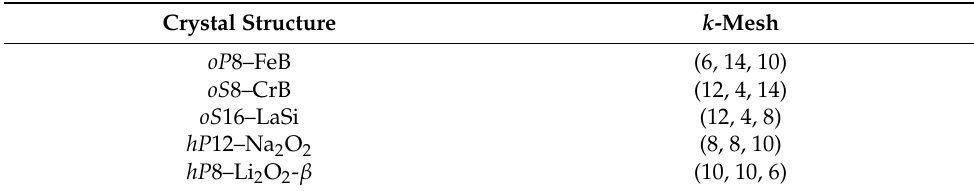
Table 2. k -point meshes employed to perform total energy calculations for the selected crystal structures.